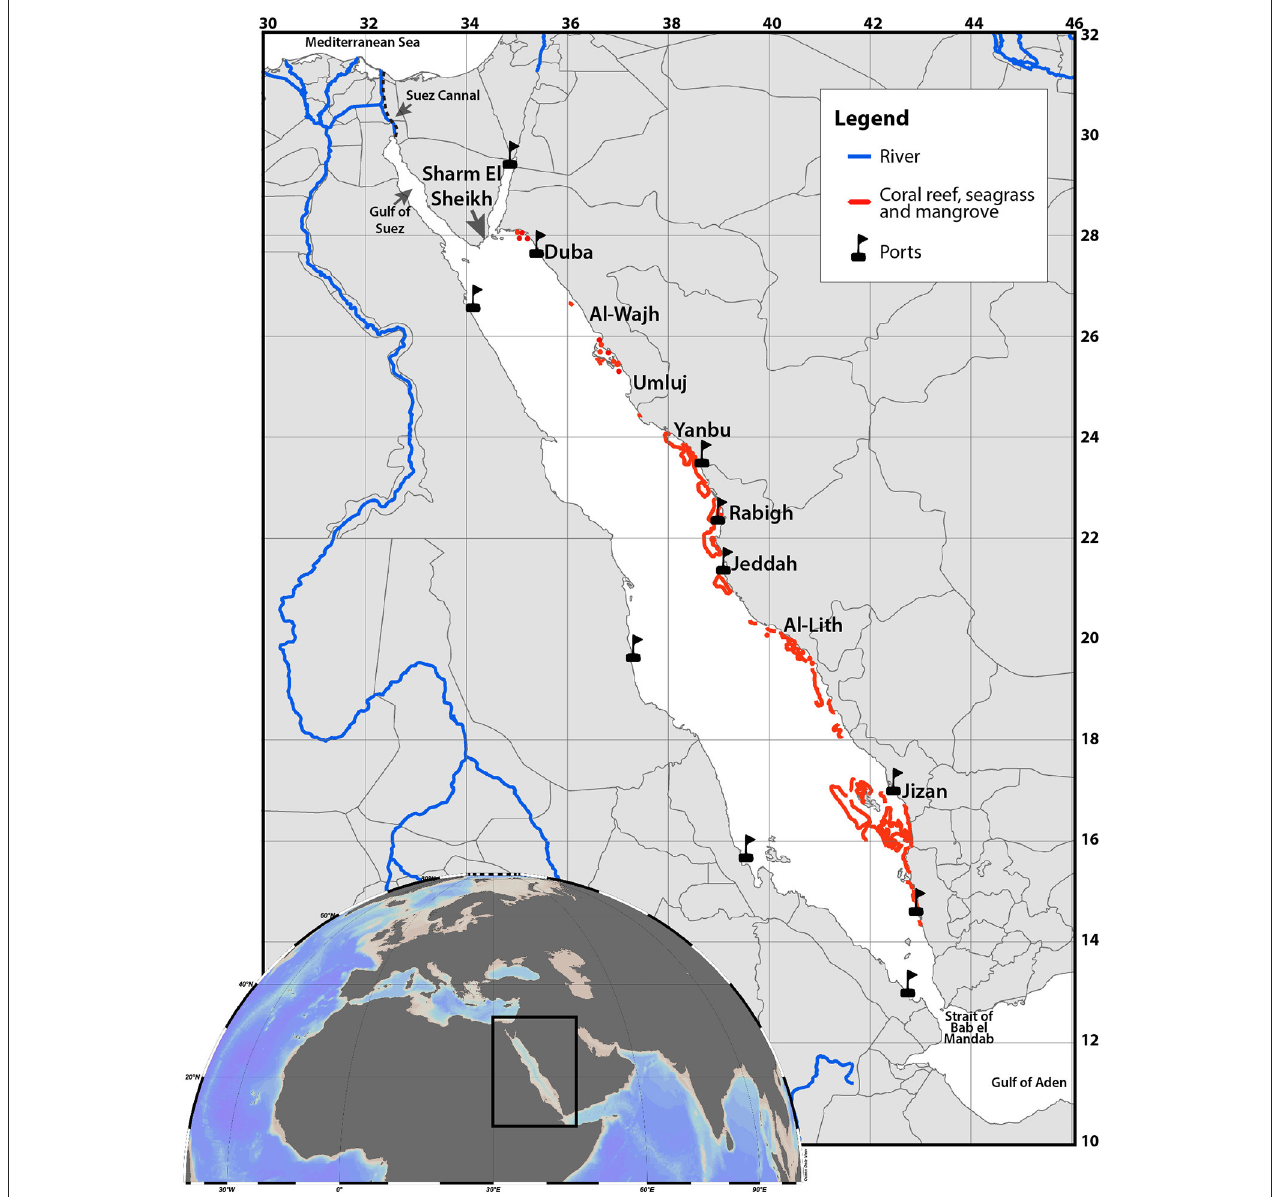
FIGURE 1 | Geographic location of the study area. Blue lines show rivers, red lines indicate coral reefs, seagrass beds and mangroves, and black flags are major ports (Adapted from Natural Earth and Bruckner et al.,